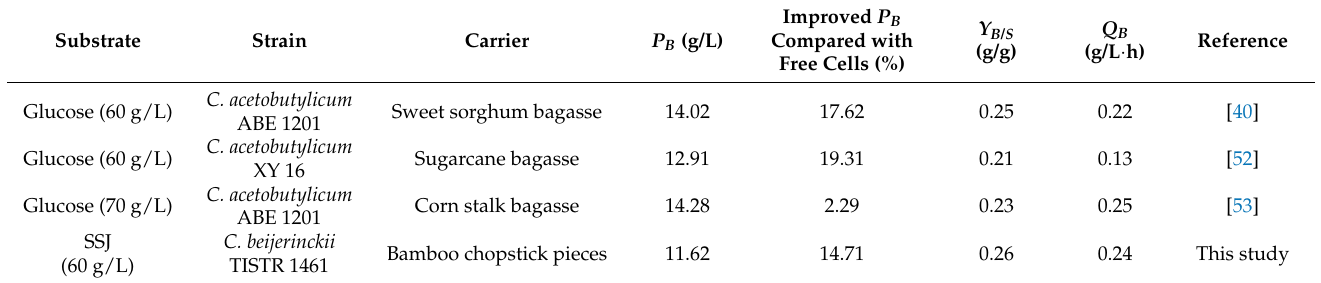
Table 11. Comparison of batch butanol fermentation efficiency levels with immobilized Clostridium cells.